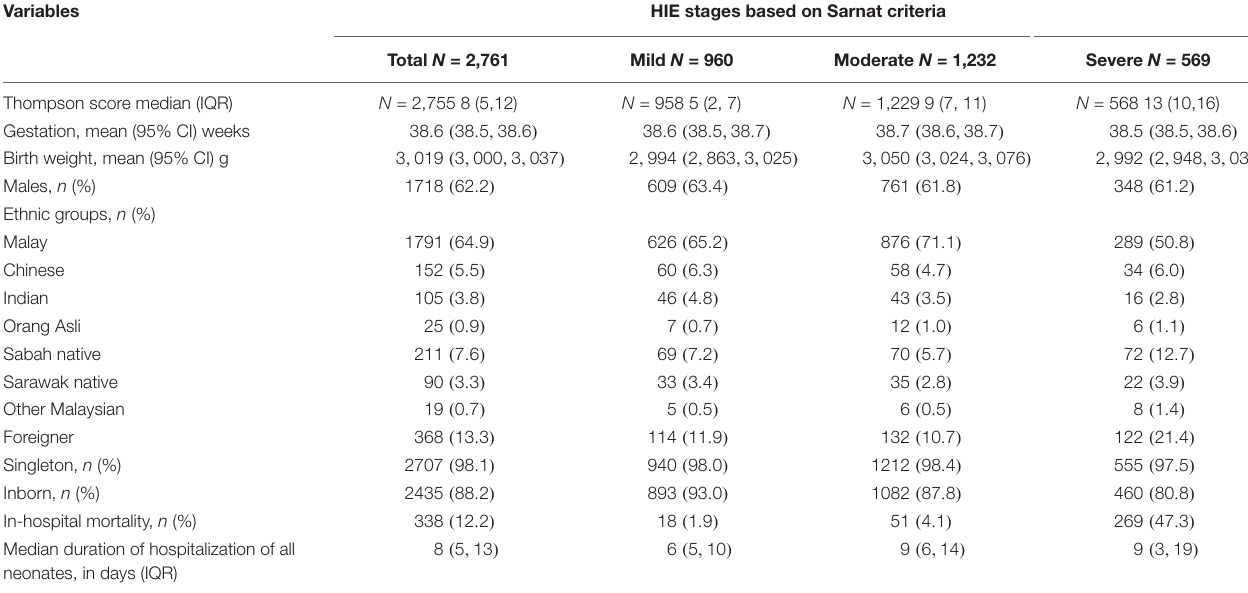
TABLE 1 | Demography and outcome of hypoxic-ischemic encephalopathy (HIE) neonates in the Malaysian National Neonatal Registry (MNNR),